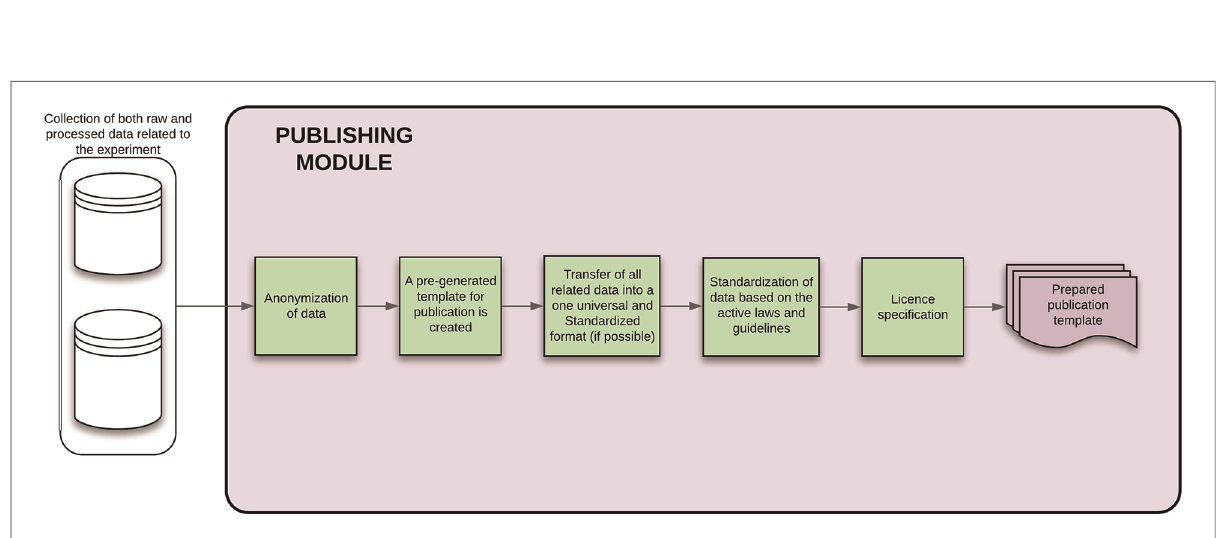
FIGURE 14 Publishing module — the fi gure describes each of the steps that will be done automatically by the module, showing also the process inputs and